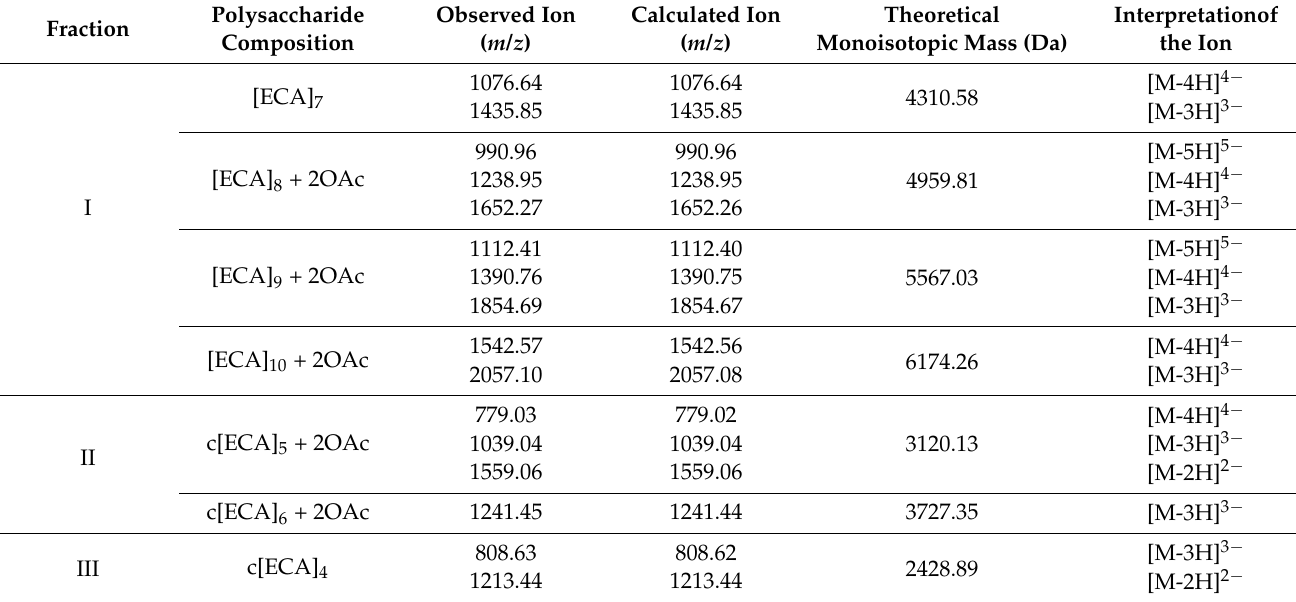
Table 2. Interpretation of main ions observed in fractions I-III from E. coli R1 supernatant (ESI-MS, negative ion mode, [M-nH] n − ions).